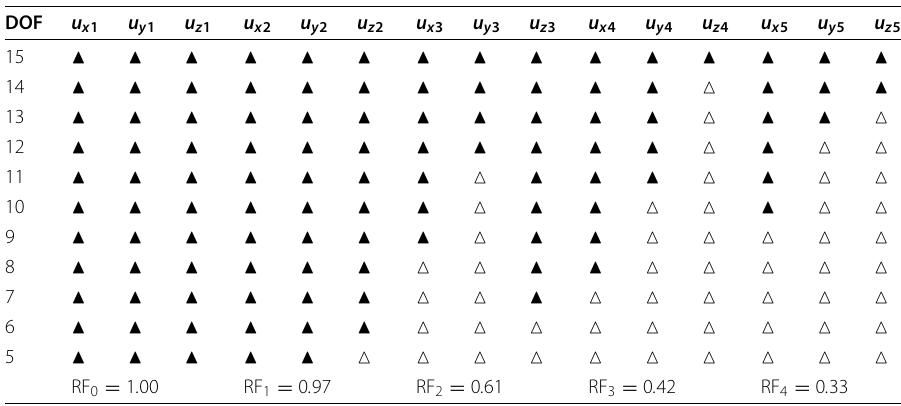
Table13 BTD models for 0/90/0/90, R/a = 5 , a/h = 100 ,